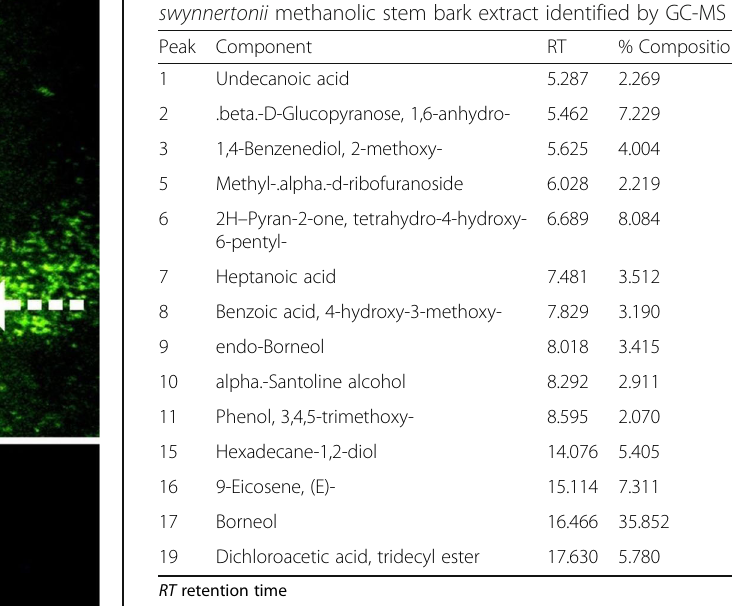
Table 4 Major phytochemical components from Commiphora